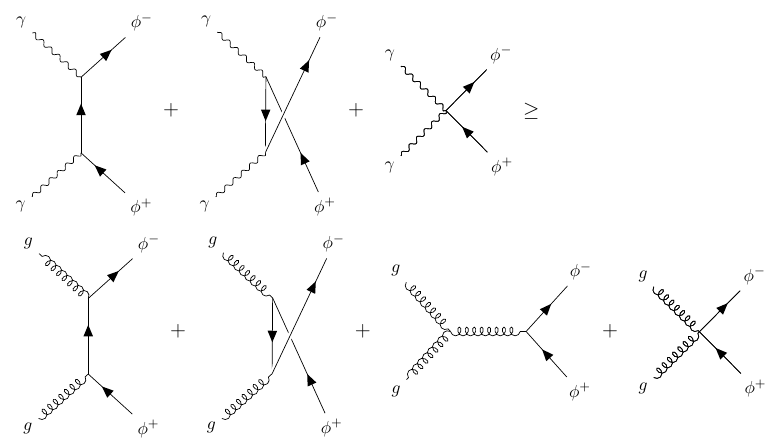
Figure 1 . The relevant tree level diagrams for the pair production of charged scalars in SQED and linearized Einstein gravity. We assign the letter A to the diagrams with photons and the letter C to the production via